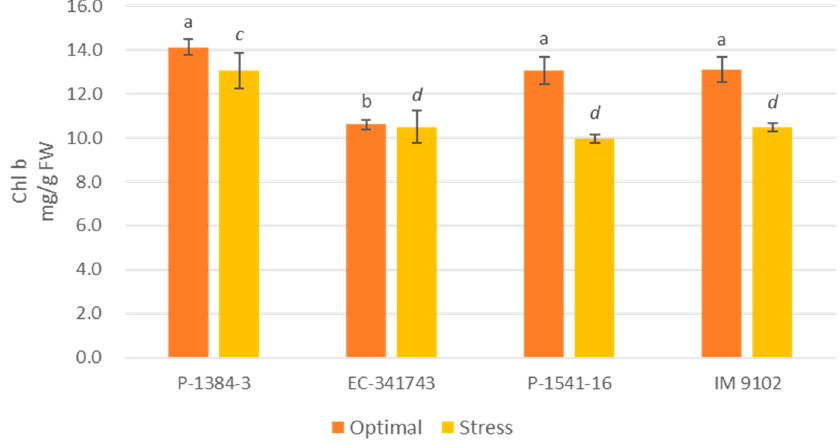
Figure 1. Chlorophyll-a content of four field pea genotypes under optimal and heat stress. Columns with different letters indicate significant difference at p ≤ 0.05 (Fisher LSD test).